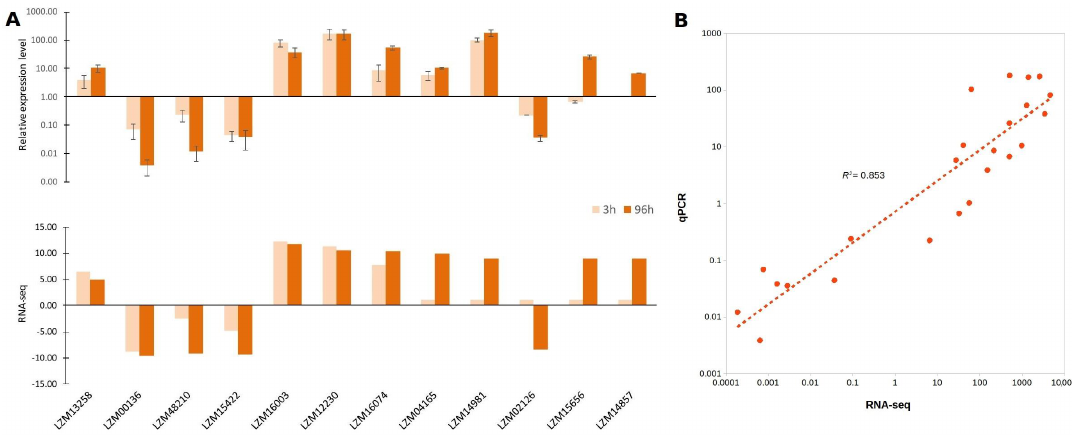
Figure 6. Validation of RNA sequening (RNA-seq) results by reverse transcription-quantitative PCR (RT-qPCR) of the differentially expressed lncRNAs in response to salt and boron stress. ( A ) Comparisons between qPCR validation, compared to RNA-seq. The upper graphic represents the differential expression analysis of 10 leaves and 2 roots randomly selected lncRNAs at 3 and 96 h after exposure to 150 mM NaCl and 20 ppm B stress conditions obtained by RT-qPCR. The lower graphic represents the fold changes based on FPKM calculated from globally normalized RNA-seq data. For RT-qPCR, the Cullin gene was used on the normalization of gene expression. The values are presented as an average and standard error (SE) of three independent experiments, with three technical replicates; ( B ) Correlation analysis according to qPCR and RNA-seq